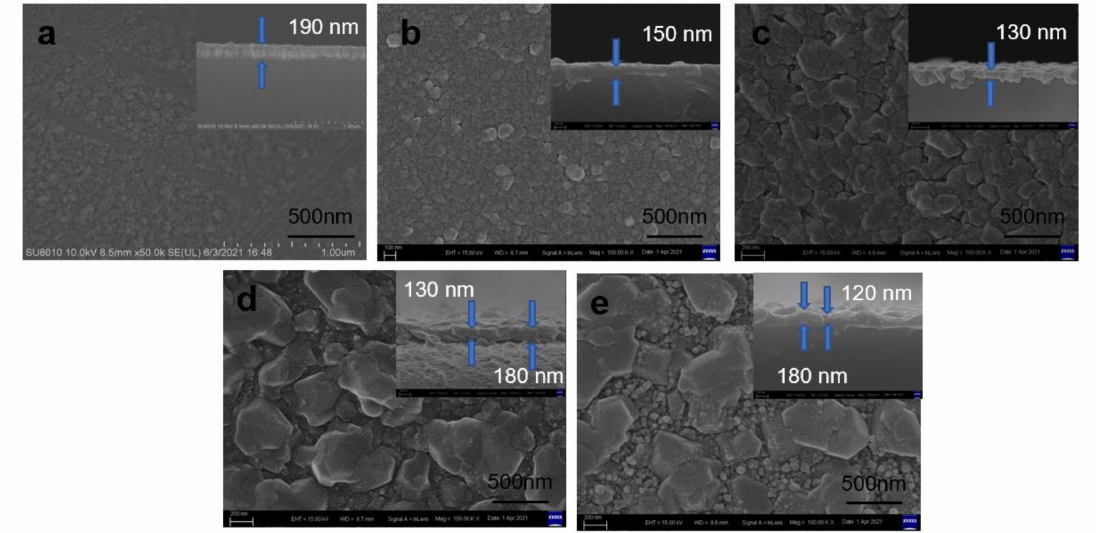
Figure 3. The morphologies of Al films at different deposition temperature: ( a ) RT, ( b ) 100 ◦ C, ( c ) 200 ◦ C, ( d ) 300 ◦ C, ( e ) 400 ◦ C. (The insets are the corresponding cross-sectional